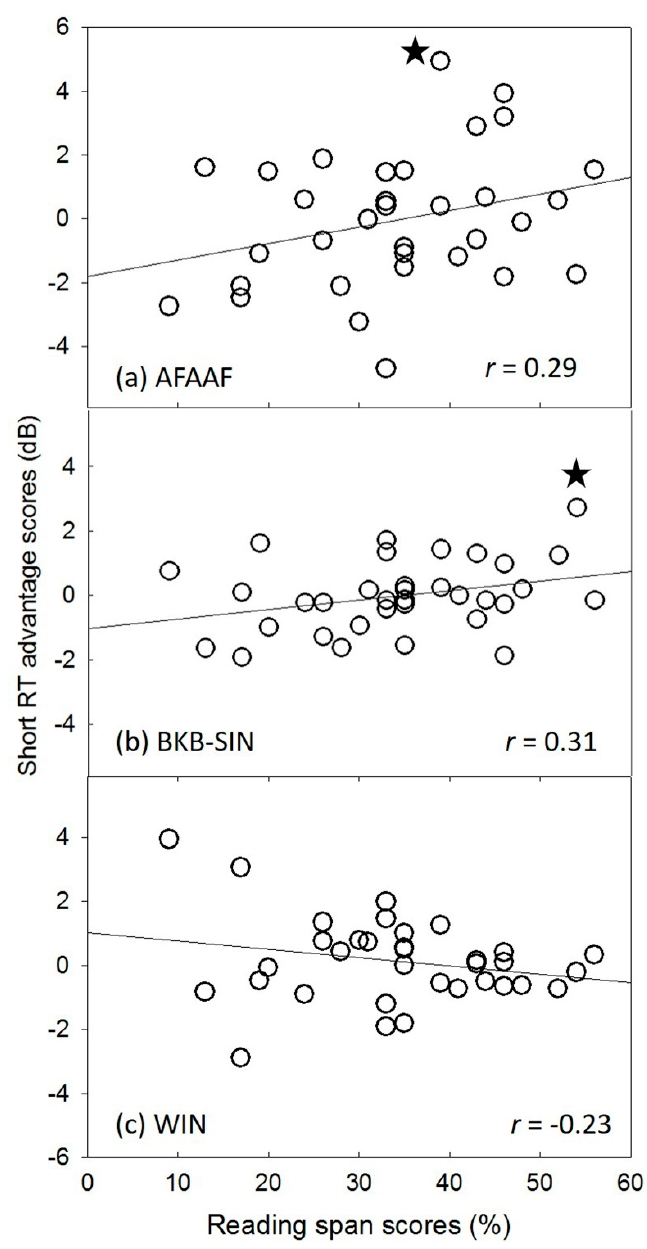
Figure 5. Scatter plots showing the relationship between the reading span scores and Benefit- ShortRT scores for the three speech recognition tests: ( a ) American four alternative auditory feature (AFAAF) test; ( b ) Bamford-Kowal-Bench speech-in-noise (BKB-SIN) test; ( c ) word-in-noise (WIN) test. The solid line in each of the sub-plots is the regression line. The star symbols indicate the data points that were adjusted.